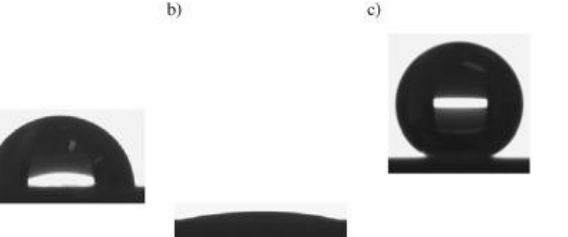
Figure 11. Wettability of ( a ) untreated, ( b ) anodized, and ( c ) superhydrophobic aluminum after low-pressure deposition of a plasma-polymerized hydrophobic coating from Ar/HMDSO discharges. Reproduced with permission from [85].